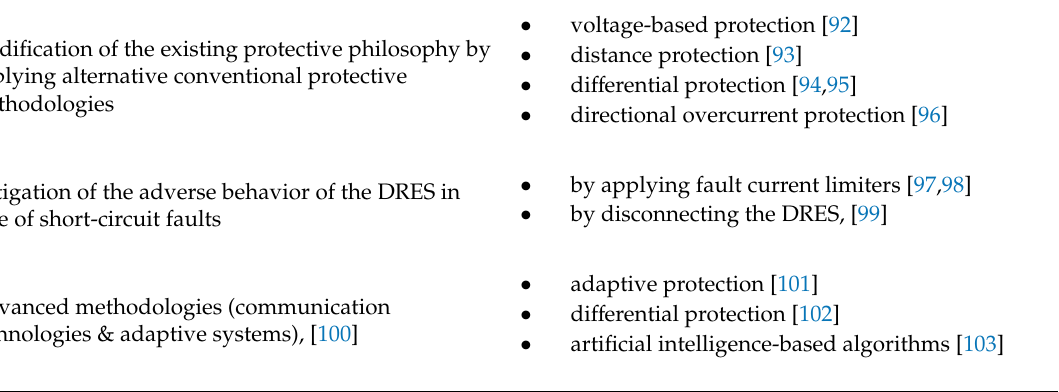
Table 1. Fault-clearing methods in distribution systems- a